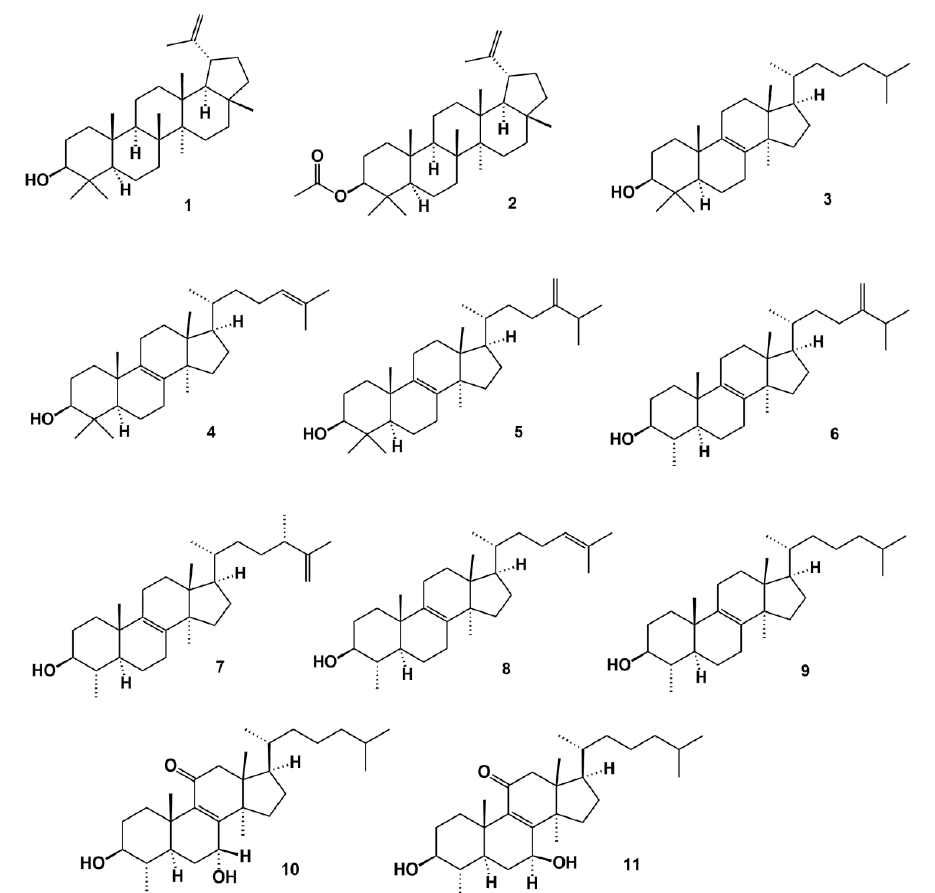
Figure 3. Triterpenic ( 1 and 2 ) and steroid compounds isolated and identified in the Moroccan latex of Euphorbia officinarum .